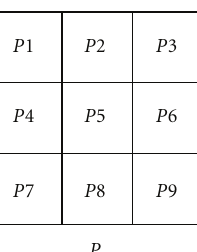
Figure 5: The schedule of the entries ( p 1 to p 9) of the pattern vector P